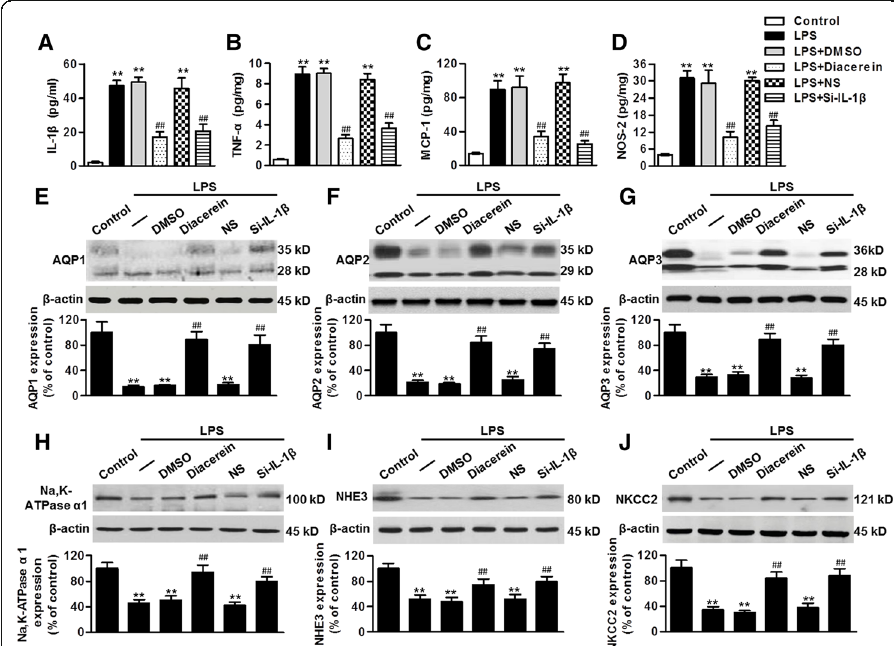
Fig. 6 Effects of diacerein and IL-1 β inhibition on AQP and sodium transporter expression after LPS treatment in HK-2 cells. a-d The cells were pretreated with diacerein (1 μ M) for 1 h, interleukin-1 β (IL-1 β ) siRNA (Si- IL-1 β ), or negative siRNA (NS) for 48 h before lipopolysaccharide (LPS, 1 μ g/mL) incubation for a further 48 h. Levels of IL-1 β ( a ), tumor necrosis factor- α (TNF- α ) ( b ), monocyte chemoattractant protein-1 (MCP-1) ( c ) and nitric oxide synthase 2 (NOS-2) ( d ) induced by LPS were inhibited by diacerein or IL-1 β siRNA treatment. e - j Protein expression of aquaporin 1 (AQP1) ( e ), AQP2 ( f ), AQP ( g ), Na,K-ATPase α 1 ( h ), apical type 3 Na/H exchanger (NHE3) ( i ) and Na-K-2Cl cotransporter (NKCC2) ( j ) was examined by western blotting. LPS-induced decreases of AQP and sodium transporter expression were attenuated by diacerein or IL-1 β siRNA treatment. ** P < 0.01 vs. control, ## P < 0.01 vs. LPS, n =